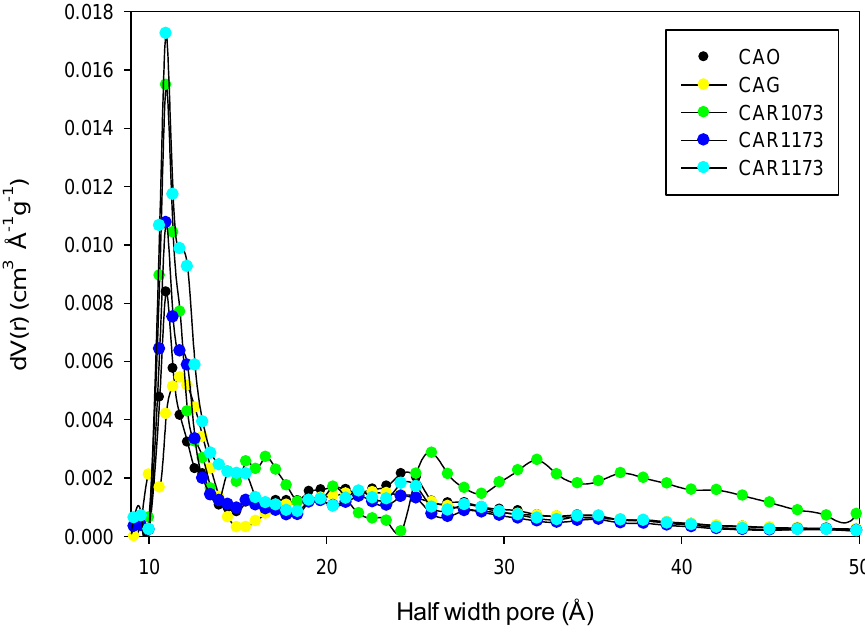
Figure 1. Pore size distributions of the activated carbons CAO, CAG, CAR1073, CAR1173, and CAR1273.